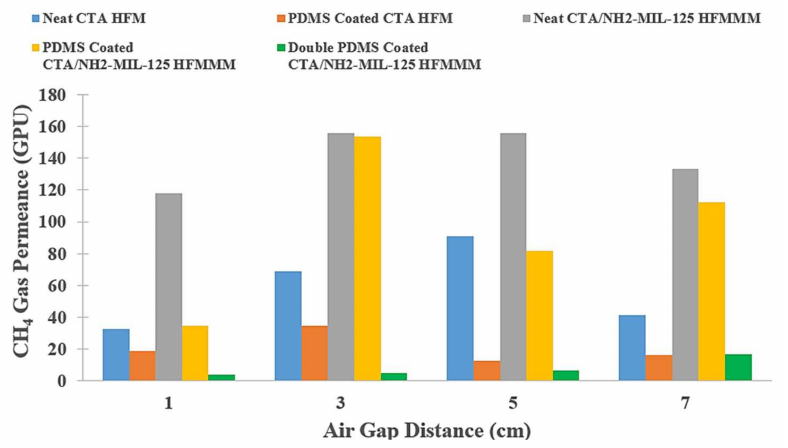
Figure 7. CH 4 gas permeance for the fabricated fibers at various air gap distances.